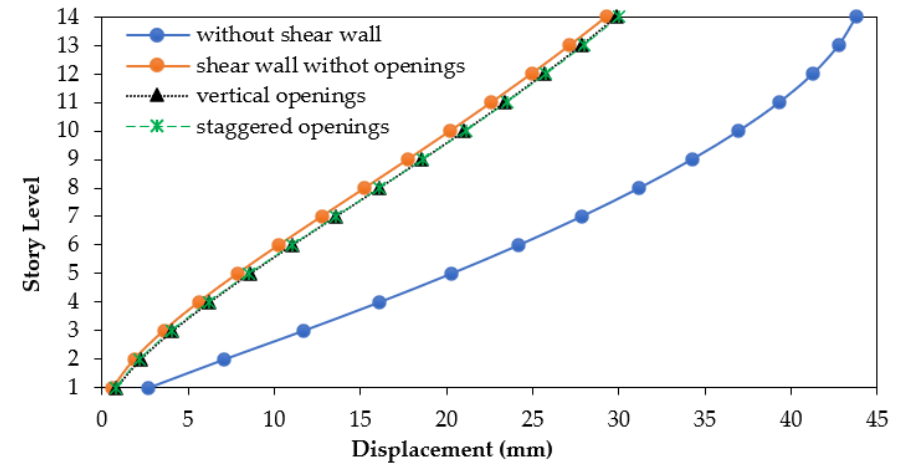
Figure 10. Story displacement of the models, response spectrum analysis, Y-direction. Table 8. Comparison of the story displacements, time history, and X-direction (mm).